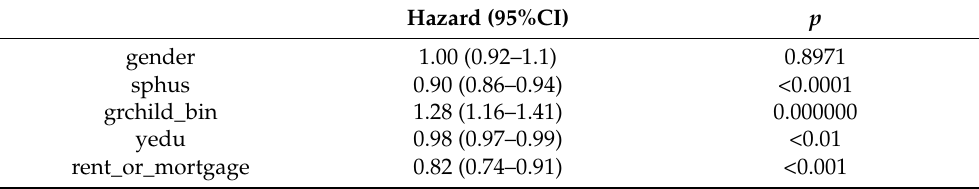
Table 6. Summary of Cox regression of retirement with time-dependent covariates. Hazard (95%CI) p gender